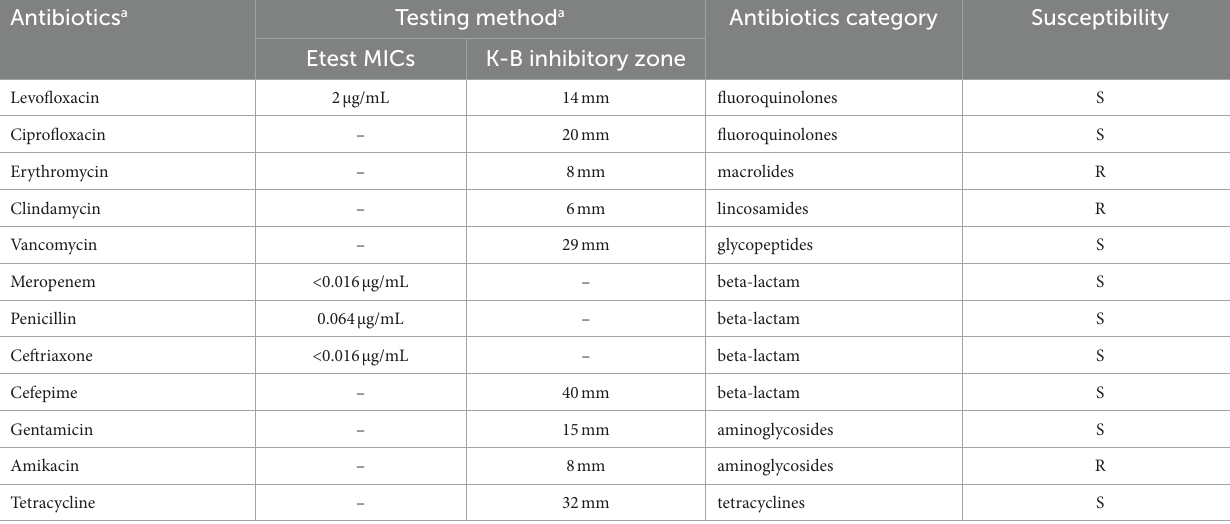
TABLE 1 Antibiotic susceptibility of strain